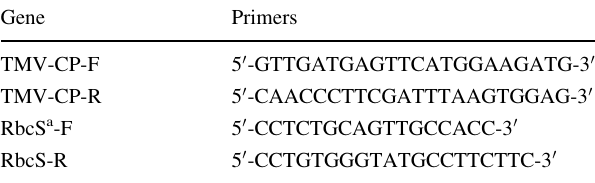
Table 2 Sequences of gene-specific primers used in RT-PCR analysis Gene